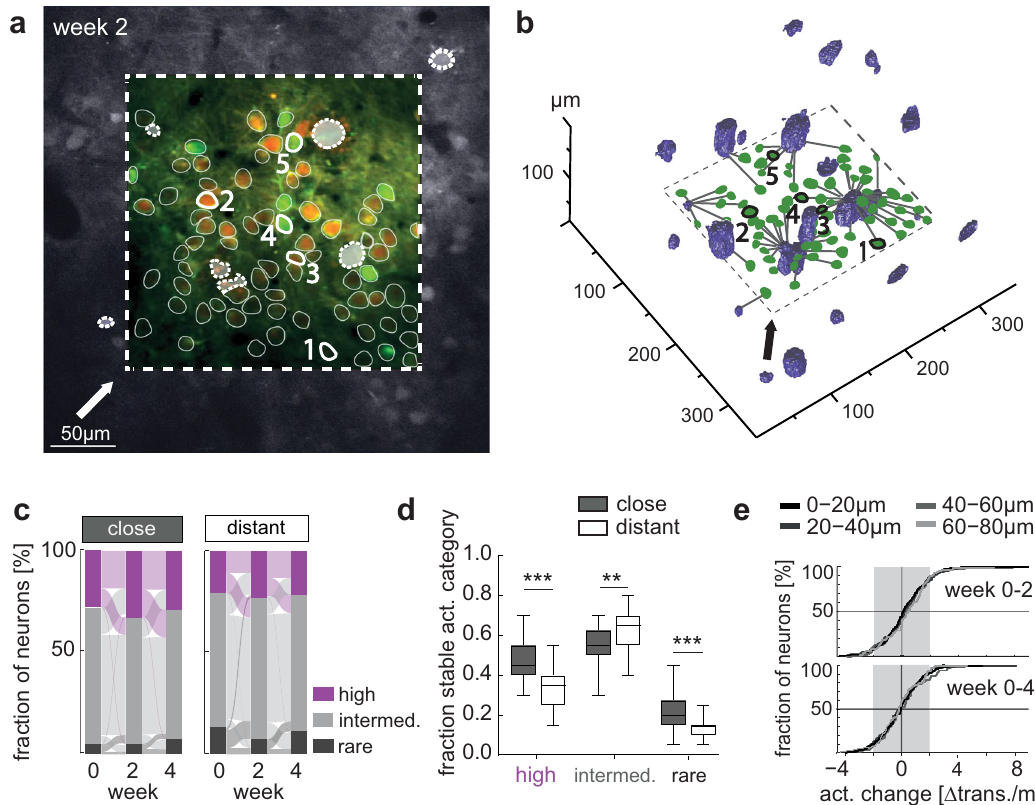
Fig. 5 Impact of amyloid plaque proximity on the dynamics of neuronal activity. a Representative FOV (dashed rectangle) within a plane of a z-stack (shown is the mRuby2 channel in grey scale), used to measure the distances between plaques and neurons; GCaMP6s (green), mRuby2 (red), plaques (location of plaques is derived from the methoxy-XO4 channel and indicated by dashed lines). Selected ROIs are identical in a , b . The arrow indicates the viewing angle in b . b 3D reconstruction of the imaged area shown in a ; plaques (blue) and the ROIs (green). Lines connecting ROIs and plaques represent the shortest distance between a neuron and the closest plaque border. c Relative proportions of highly, intermediately and rarely active neurons and their fractional change over time in APPPS1 mice for close (< = 40 µ m) and distant (>40 µ m from plaque border) neurons. Relative proportions of activity categories did not differ and were stable over time (fraction highly active neurons: effect of group: F 1,56 = 0.44, p = 0.51, effect of time: F 2,56 = 0.13, p = 0.88, group-by-time interaction effect: F = 0.78, p = 0.46, fraction of intermediately active neurons: effect of group: F = 0.18, p = 0.68, effect 2,56 1,56